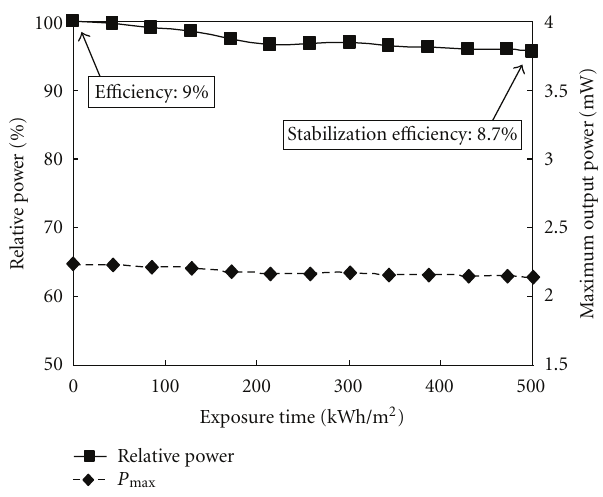
Figure 7: The maximum output power and relative power of the a- Si/a-Si tandem solar cells with the p + recombination and the thick- ness ratio of 6 as a function of the exposure